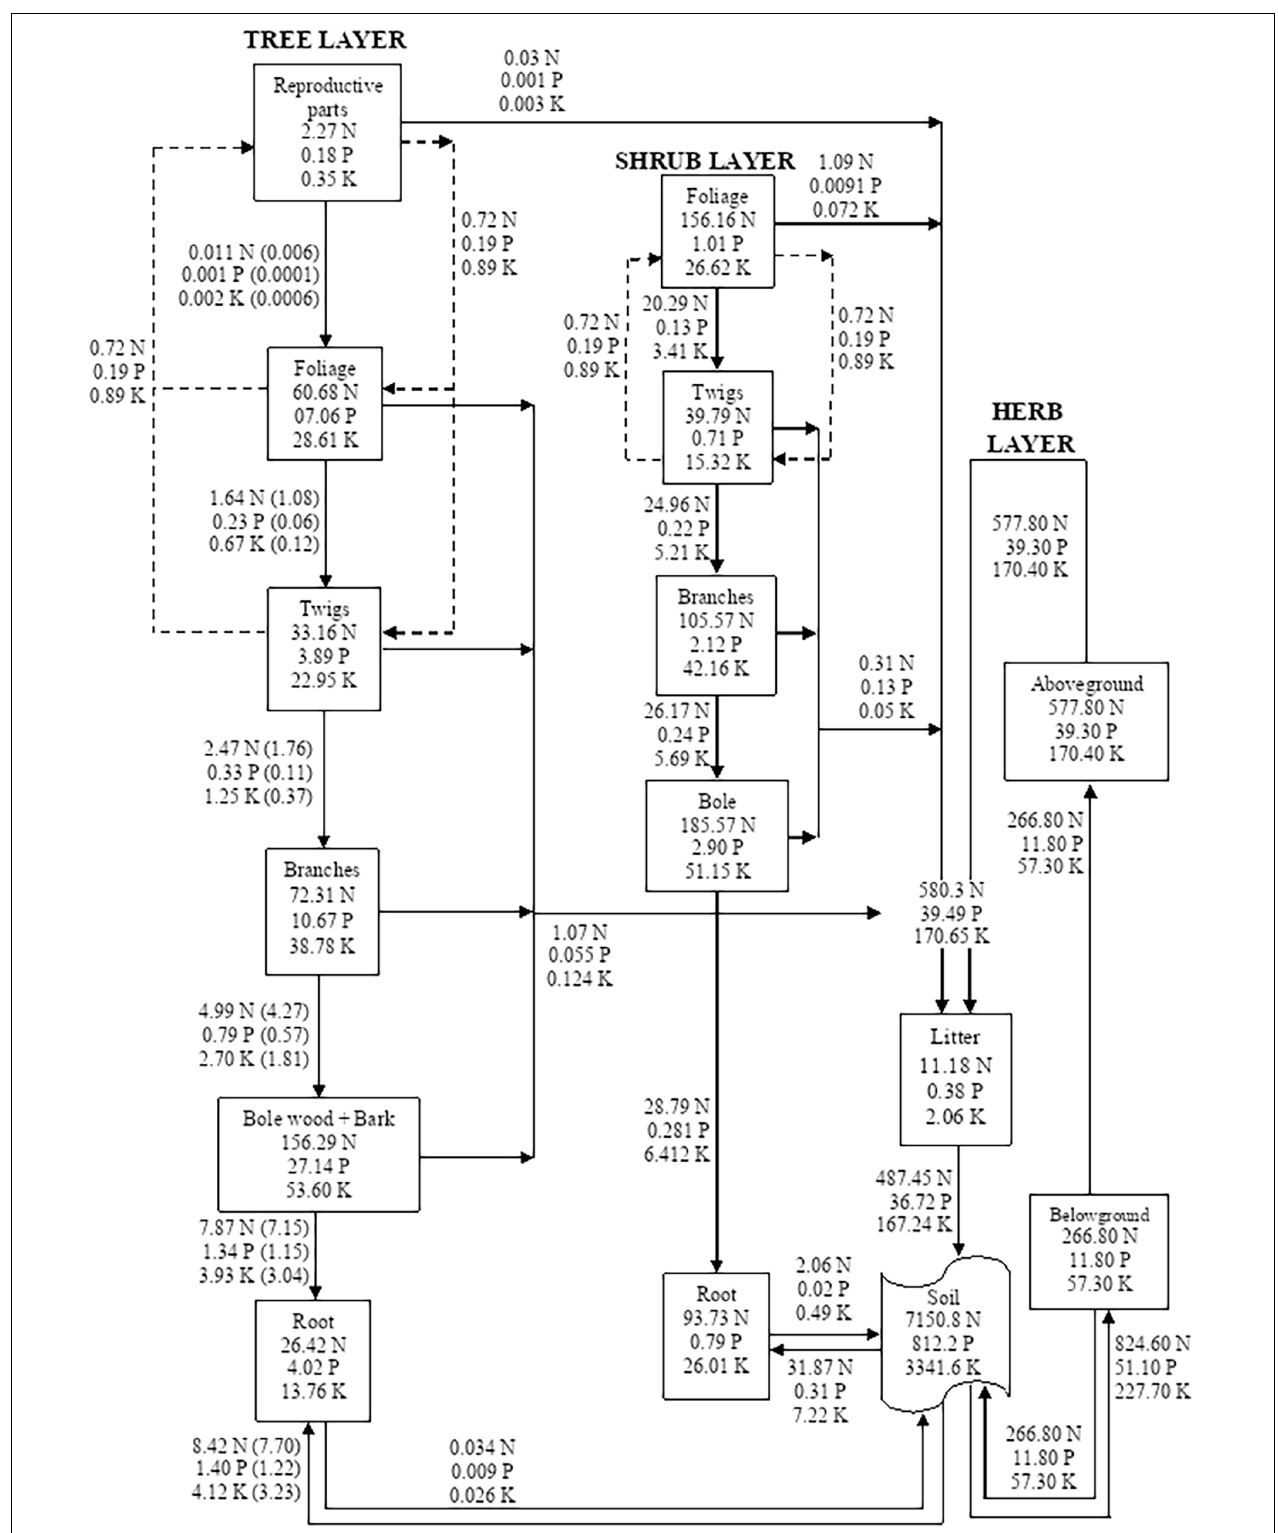
FIGURE 2 | Compartment models showing the distribution and cycling of nitrogen (N), phosphorus (P), and potassium (K) in tree, shrub, and herb at site-2. Rectangle represents a compartment for standing state of nutrients from one compartment to the next compartment. Units are kg ha − 1 yr − 1 for flows between compartments. Values in parenthesis are after adjustment for internal cycling. Recycling between reproductive parts, foliage, twigs, and bole is shown by dotted lines.